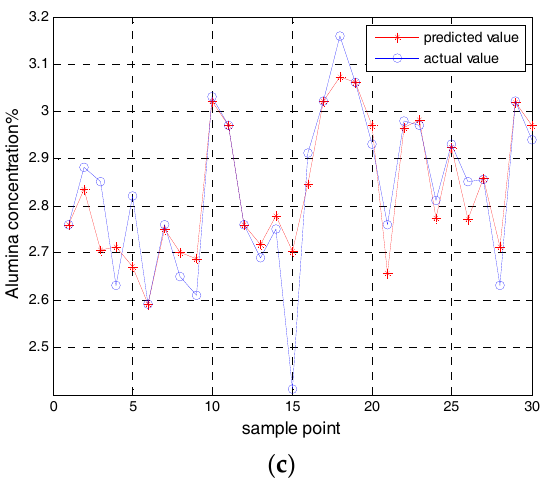
Figure 5. The predicted results of the other models. ( a ) The result of the BP model; ( b ) The result of the ELM model; ( c ) The result of the ELM model.